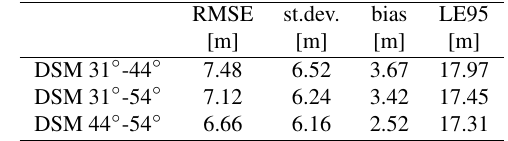
Table 2: DSMs assessment for TerraSAR-X ascending